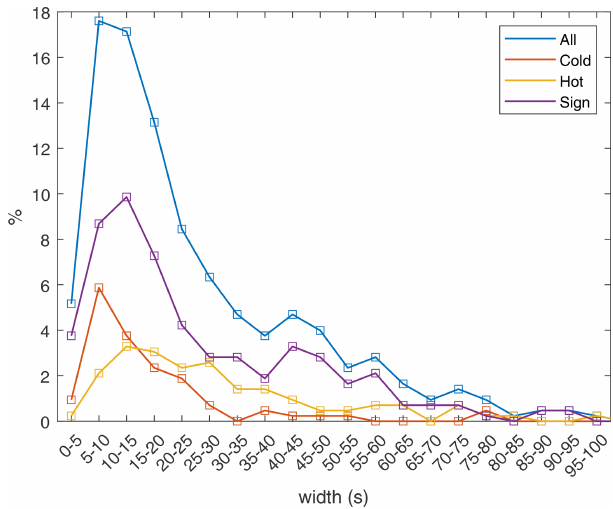
Figure 3. The distribution of the widths of the LMH structures in percentage of total events. The colour coding is the same as in Fig. 2.